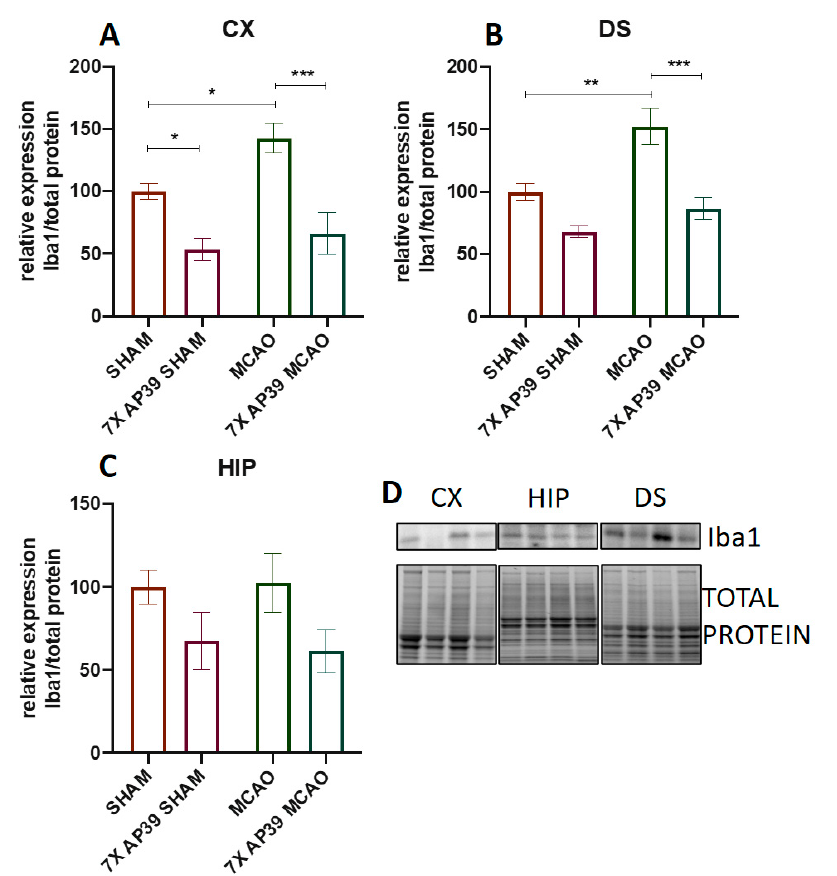
Figure 5. The influence of MCAO and AP39 on the protein expression level of Iba1 in ( A ) the frontal cortex (CX), ( B ) dorsal striatum (DS) and ( C ) in the hippocampus (HIP). ( D ) Immunoblots representative for the CX, HIP and DS for Iba1, together with the total protein amount visualized by the stain-free technique. The order of the samples is the same as in the graphs. n = 6, one-way ANOVA, followed by Sidak’s correction for post hoc comparisons; * p < 0.05, ** p < 0.01 and *** p < 0.001 vs. MCAO or SHAM. Data are presented as the mean ± SEM.